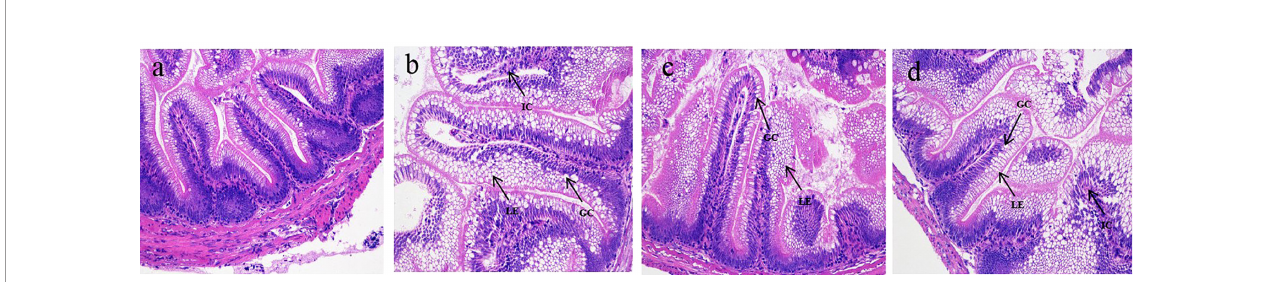
FIGURE 2 | Histological changes of the intestine in rainbow trout. (A – D) The changes of intestinal architecture in normal control (NC), challenge (IH), low-dosage (LD), and high-dosage (HD) groups, respectively. ×200 magni fi cations; GC, LE, and IC were indicative of the goblet cell, lamina epithelialis, and in fl ammatory cell,